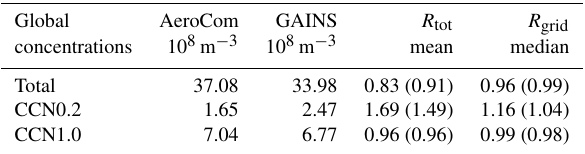
Table 4. Modeled global annually averaged concentrations of total anthropogenic particles at surface level, CCN0.2 and CCN1.0 with AeroCom and GAINS (second and third columns). Continental and (global) average ratios of total particles and CCN concentrations were calculated as in Table